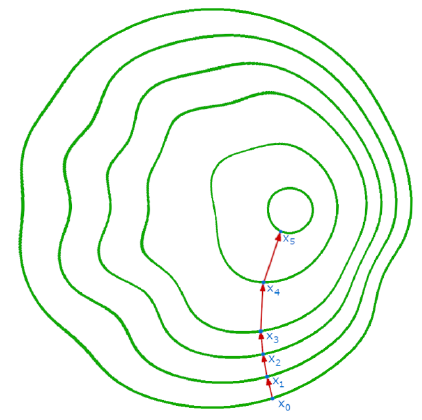
Figure 4. Schematic diagram of the non-linear programming method.